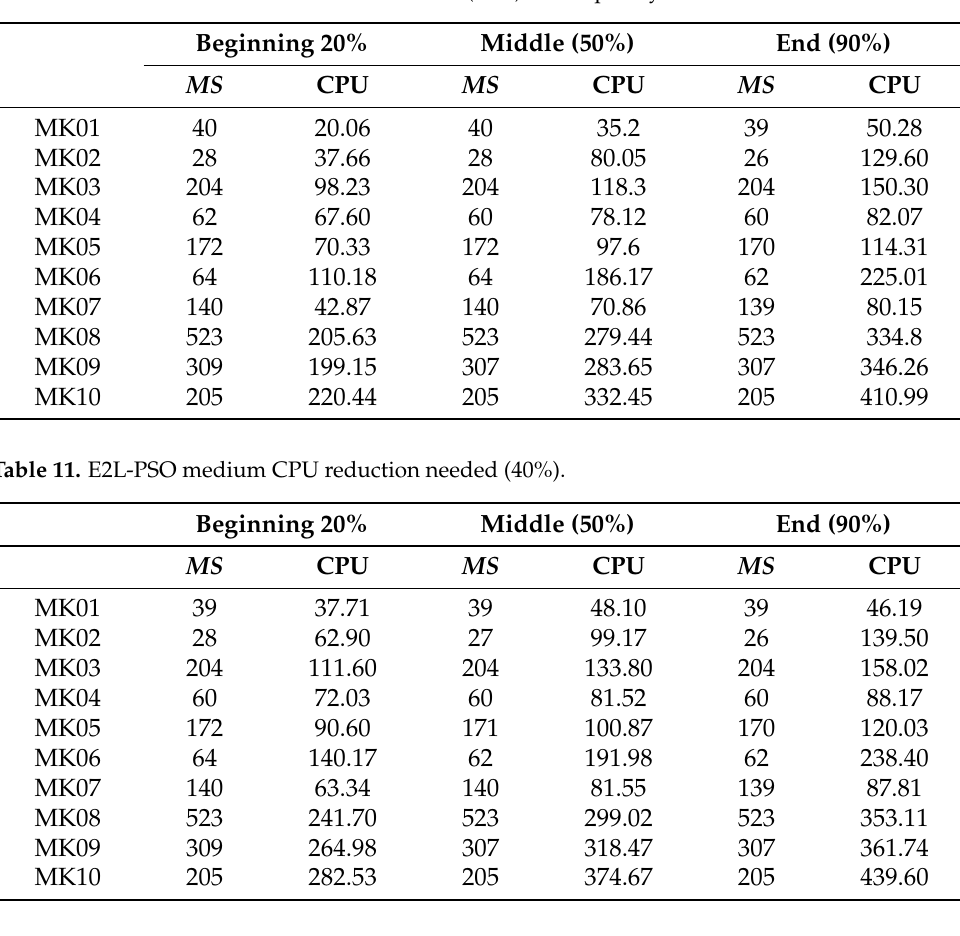
Table 10. E2L-PSO hard CPU reduction needed (60%) on Raspberry Pi B+.